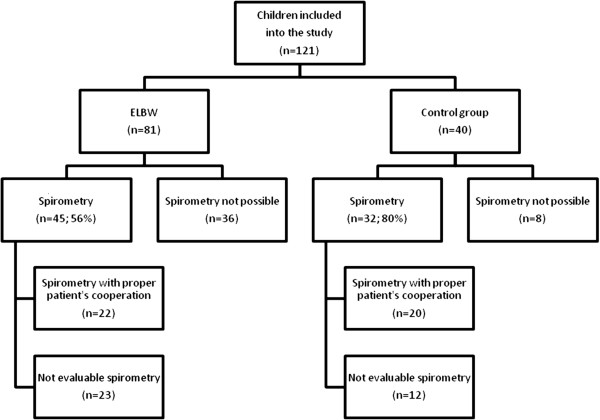
Study flow-chart.